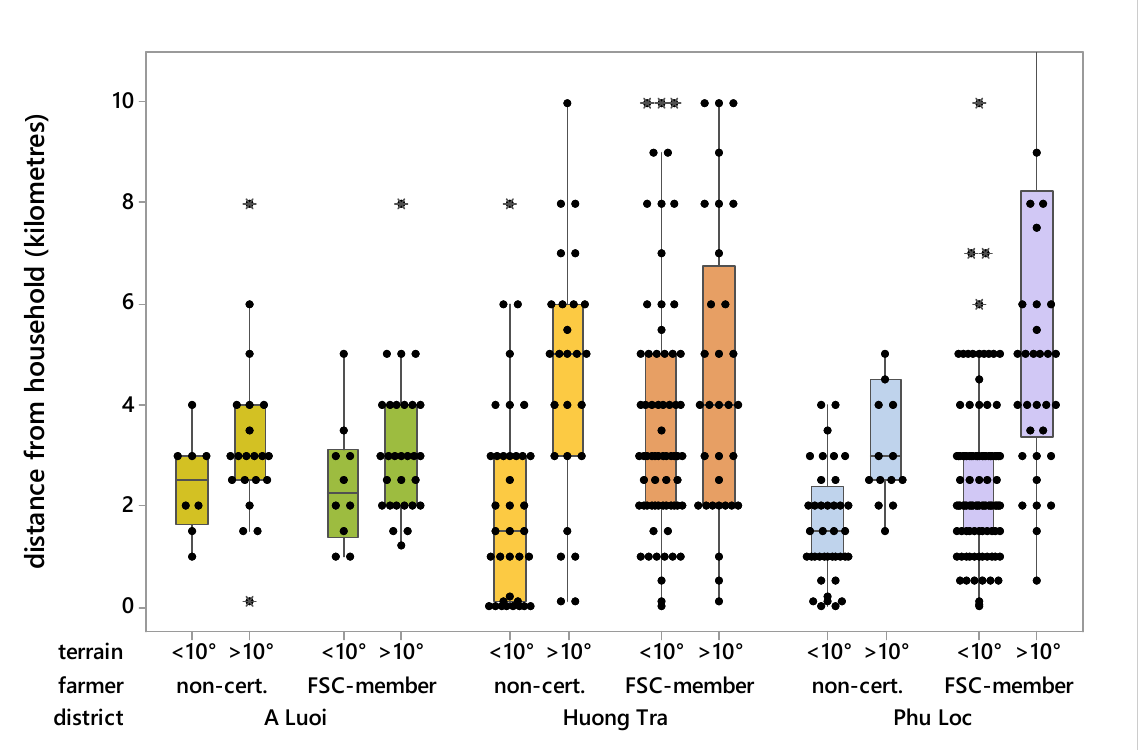
Figure 5. The distance of acacia plots from the respondents’ homesteads, by district, tree farmer type (FSC-member or farmer with only non-certified plots), and plot terrain (plot slope more or less than ~10 degrees inclination). Boxplots cf. Figure 2. Eleven outlier points in Phú L ộ c are not shown (beyond scale at distance >11 km, maximally 30 km; i.e., plots owned by three Nc- and eight FSC-farmers). All data from farmer interviews.